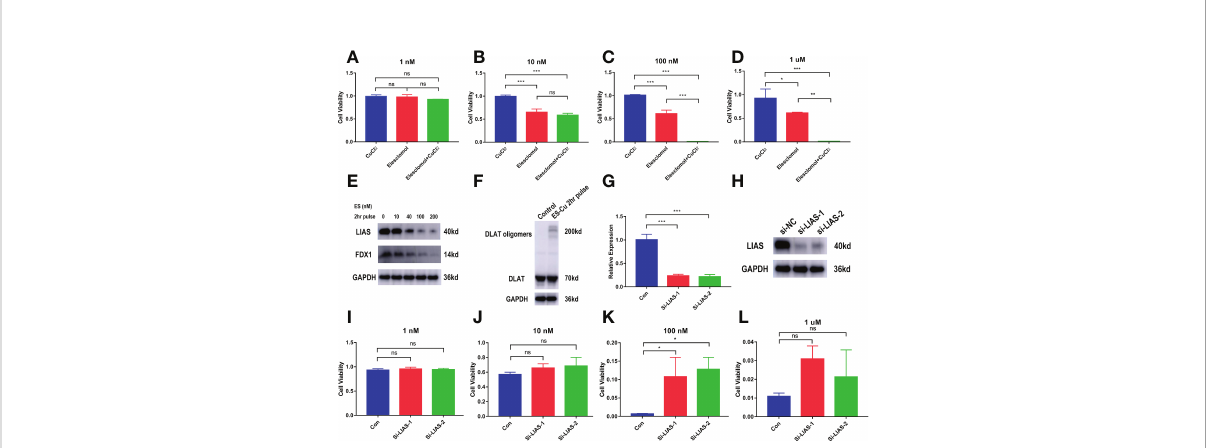
FIGURE 9 In vitro validation of the effect of cuproptosis on CCA and the role of the key gene LIAS. (A – D) CCK-8 assay demonstrating the viability of cells treated with the indicated concentration of CuCl2 or elesclomol alone or in combination for 72 h (n = 3). (E) CCLP-1 cells were analyzed for indicated proteins 24 hours after pulse treatment (2 hours) with indicated concentrations of elesclomo (media supplemented with 1µM CuCl2) (ES, elesclomo) (F) DLAT oligomerization level was detected after 2-hour pulse treatment. (G – H) The knockdown ef fi ciency of LIAS. (I-L) LIAS knockdown attenuates the toxicity of cuproptosis in the CCA cells CCLP-1 (Con, LIAS knockdown negative control. Si-LIAS, LIAS knockdown). ( ∗ p < 0.05, ∗∗ p < 0.01, ∗∗∗ p < 0.001, and ns p >